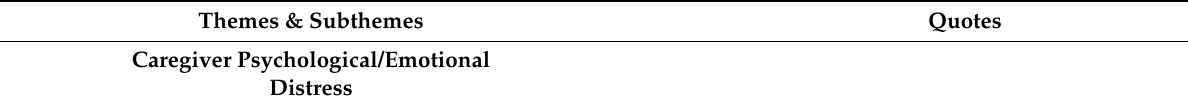
Table 3. Difficulties described, themes, and illustrative